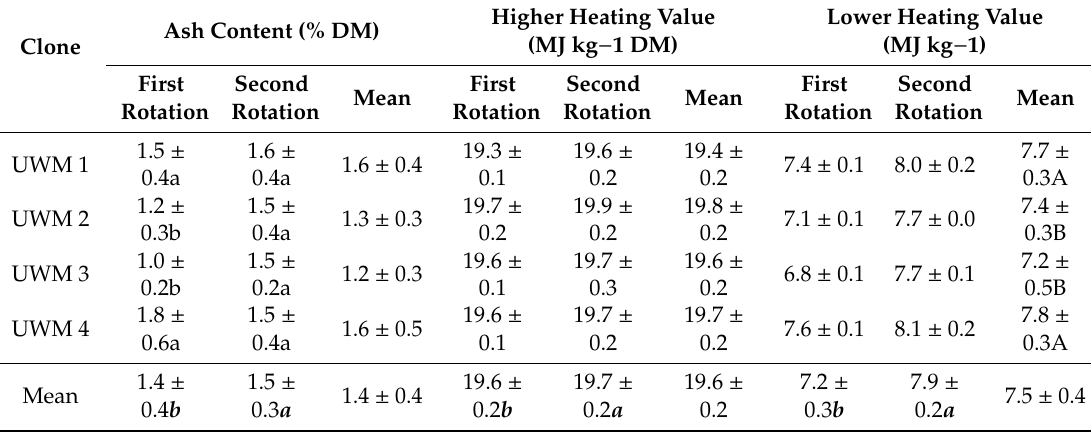
Table 4. Ash content, higher and lower heating value of biomass of four poplar clones in two consecutive 4-year harvest